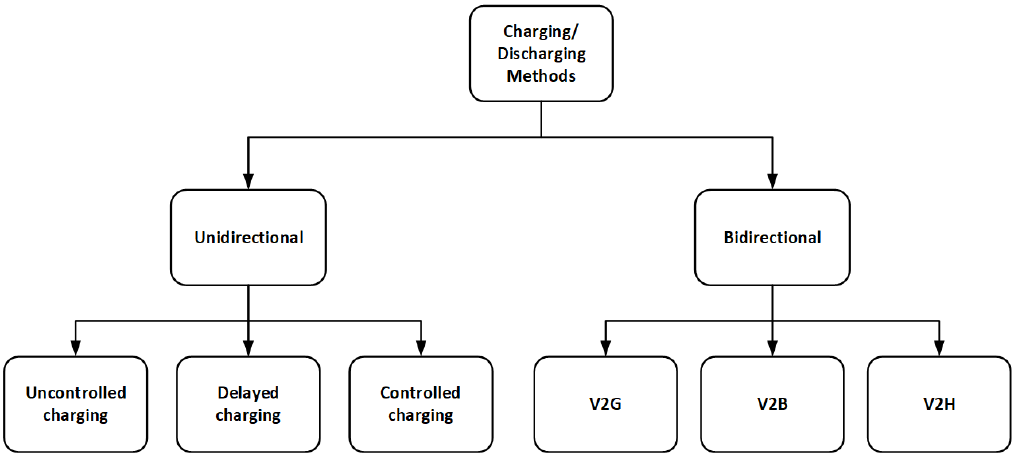
Figure 5. Classification of different charging and discharging methods.